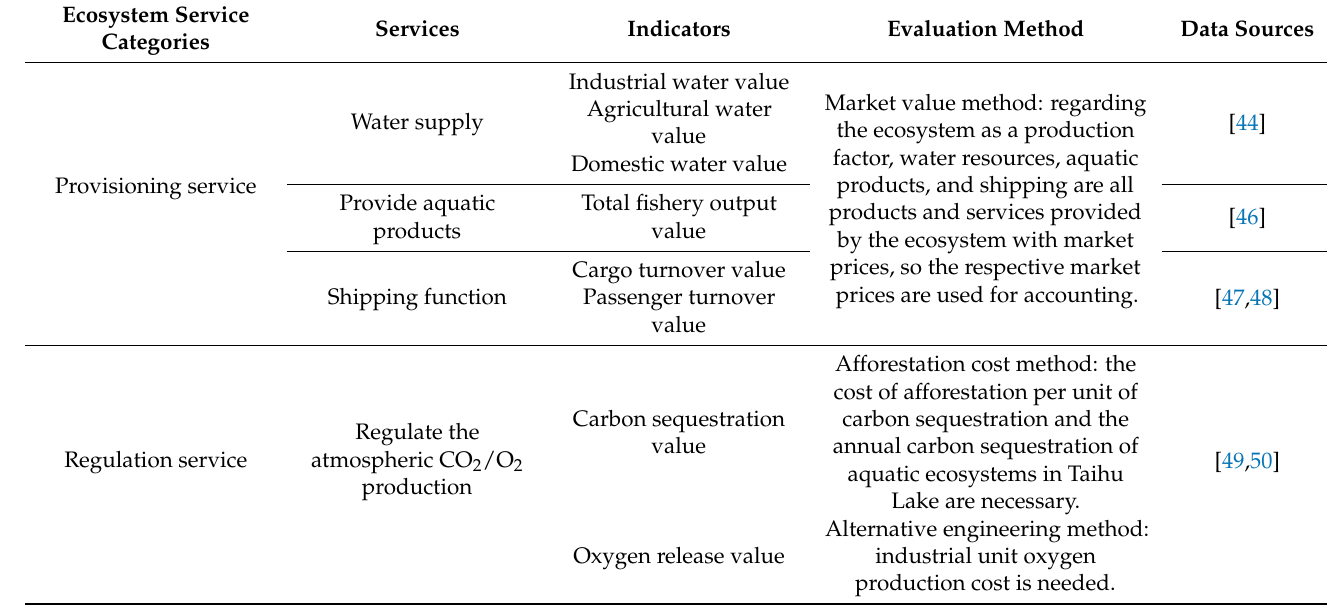
Table 4. The evaluation index system and method of Taihu Lake’s water ecosystem service